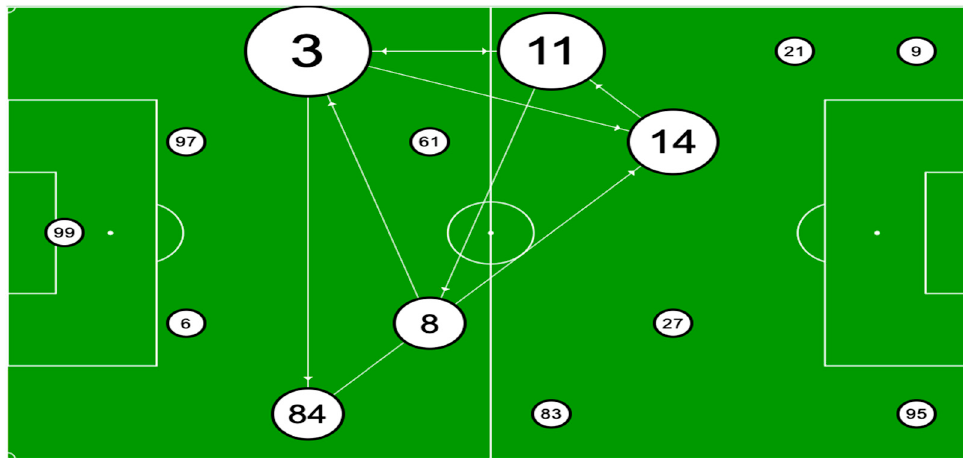
Figure 1. Network display results from team A in first half of game.